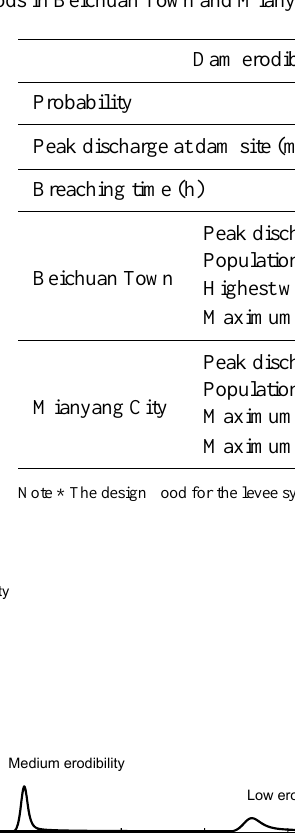
Table 5. Dam-break floods in Beichuan Town and Mianyang City in stage 1.